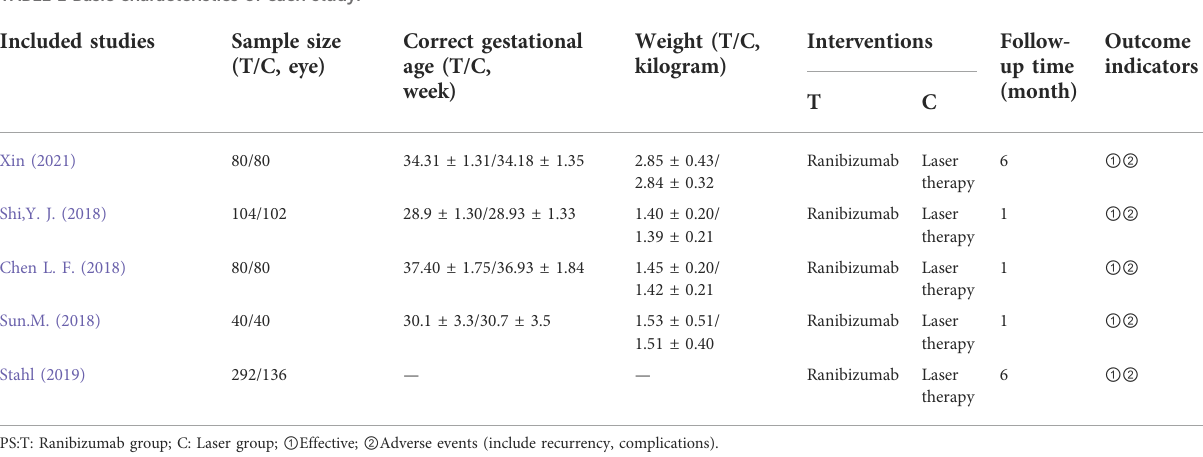
TABLE 1 Basic characteristics of each study.